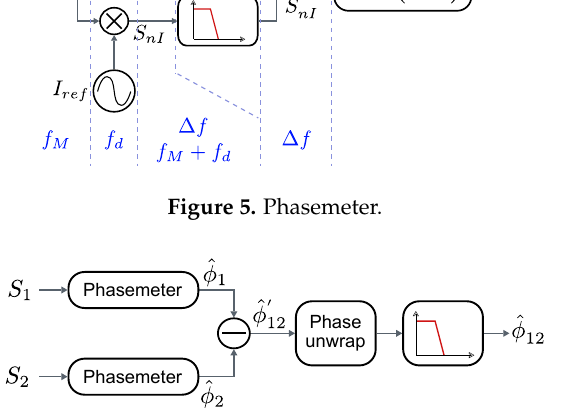
Figure 6. Differential distance estimation.